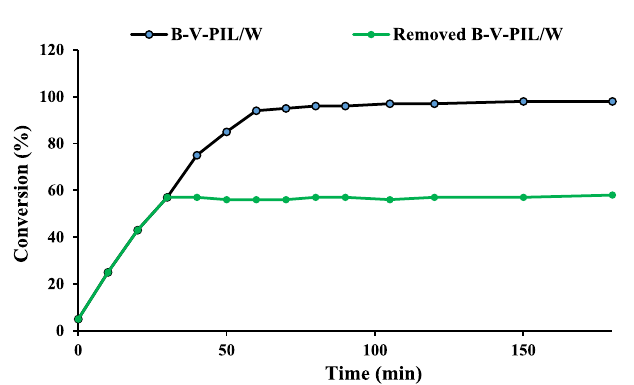
Figure 10. The result of hot filtration test for the model alcohol oxidation reaction under optimum reaction